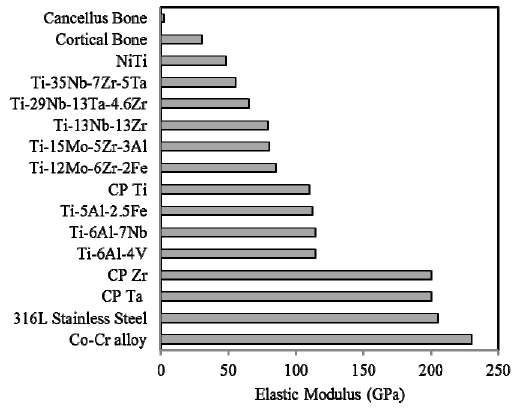
Figure 2. Elastic modulus of currently used biomedical